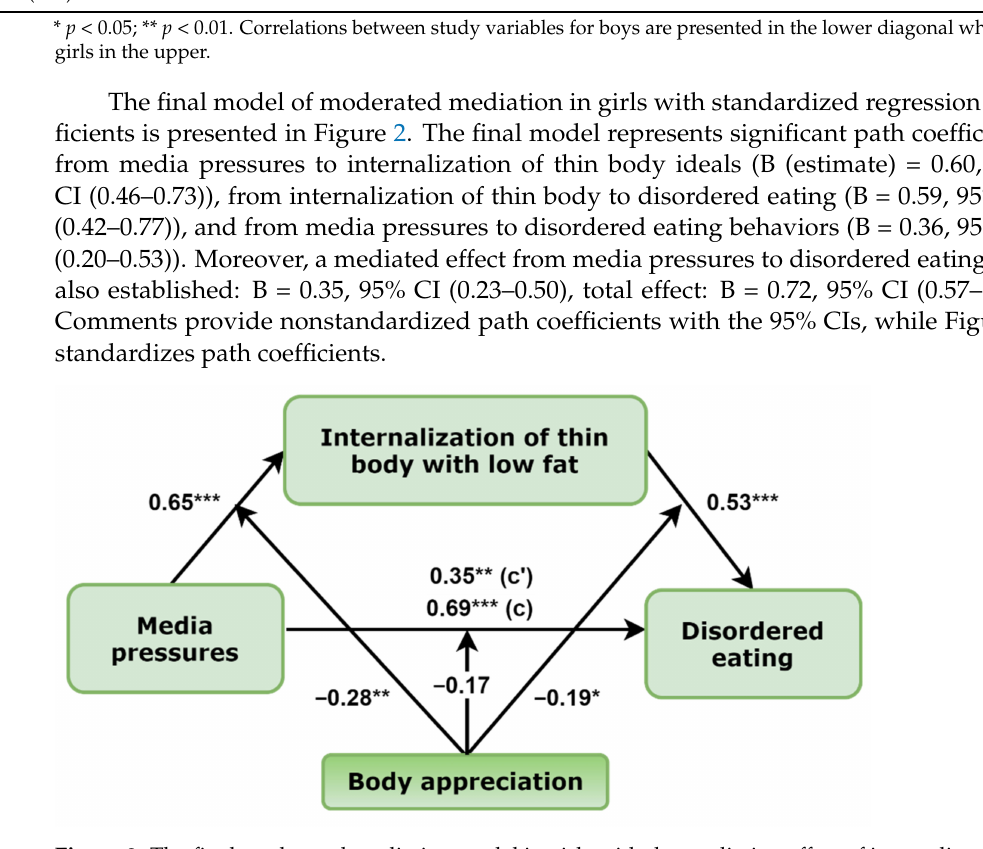
Figure 2. The final moderated mediation model in girls with the mediating effect of internalization of thin body ( n = 842). Note: standardized path coefficients are presented; c’ = direct effect, c =